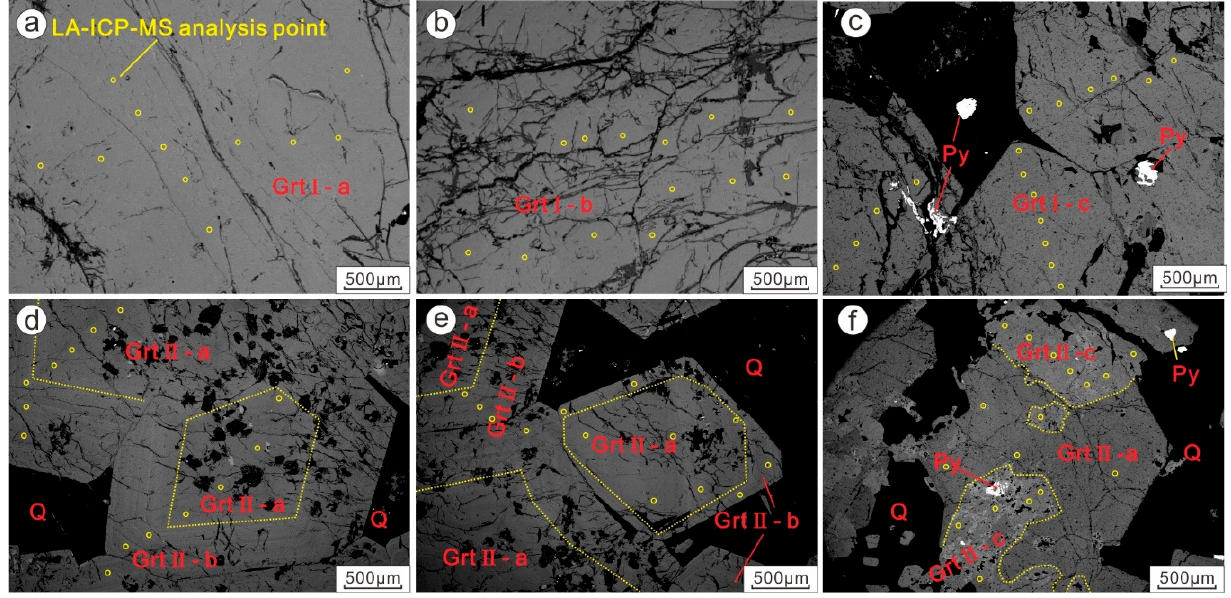
Figure 7. BSE images of the Grt I and Grt II at various stages of the Tongshanling Cu–W polymetallic deposit: ( a ) BSE image of massive Grt I-a with acyclic characteristics, ( b ) BSE image of Grt I-b, acyclic characteristics, ( c ) BSE image of Grt I-c, acyclic characteristics, pyrite can be seen in the cracks, ( d ) BSE image of Grt II-a core and Grt II-b edge, Grt II-b shows zonation features, ( e ) BSE images of Grt II-a core and Grt II-b margins, and ( f ) BSE images of Grt II-b and margin alteration region II-c showing pyrite superposition.